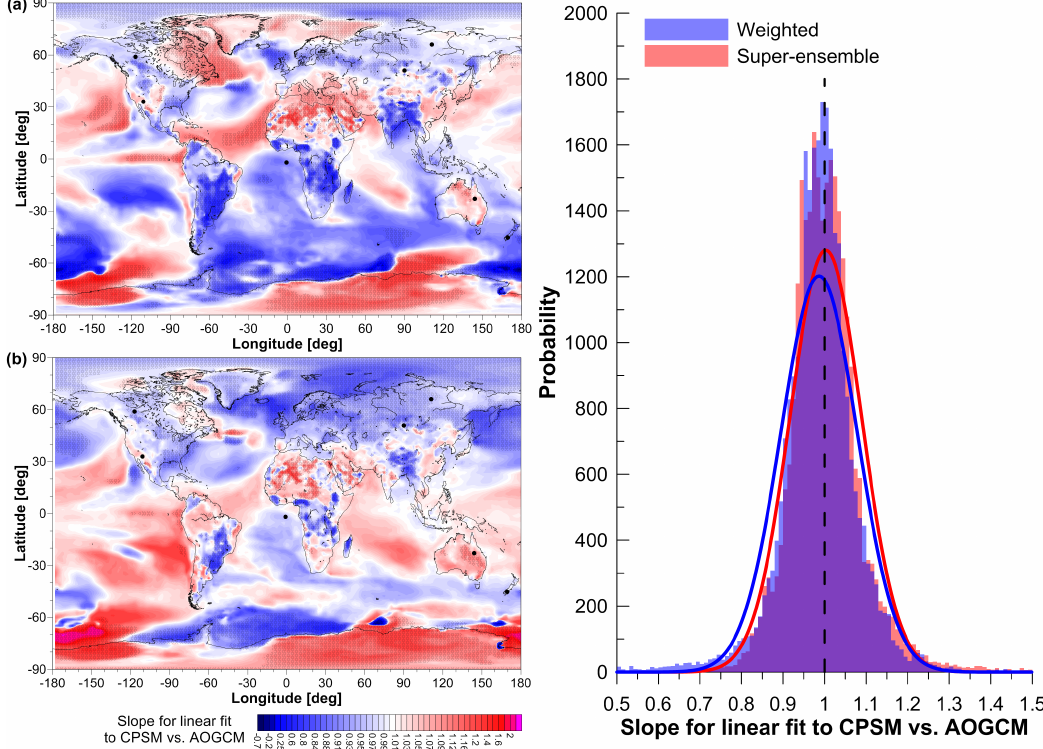
Fig. 11. The linear slopes obtained by regressing T 0 time series from the CPSM against time series obtained from HadGEM2-ES min (smoothed) using (a) the weighted contributions approach and (b) the super-ensemble approach. Stippled regions show where the slopes are not statistically significantly different from 1.0 at the 2 σ level. Small black dots show the locations of the sites from Fig. 10. The rightmost panel shows the PDF of the linear slopes for both the weighting contributions approach and the super-ensemble approach.